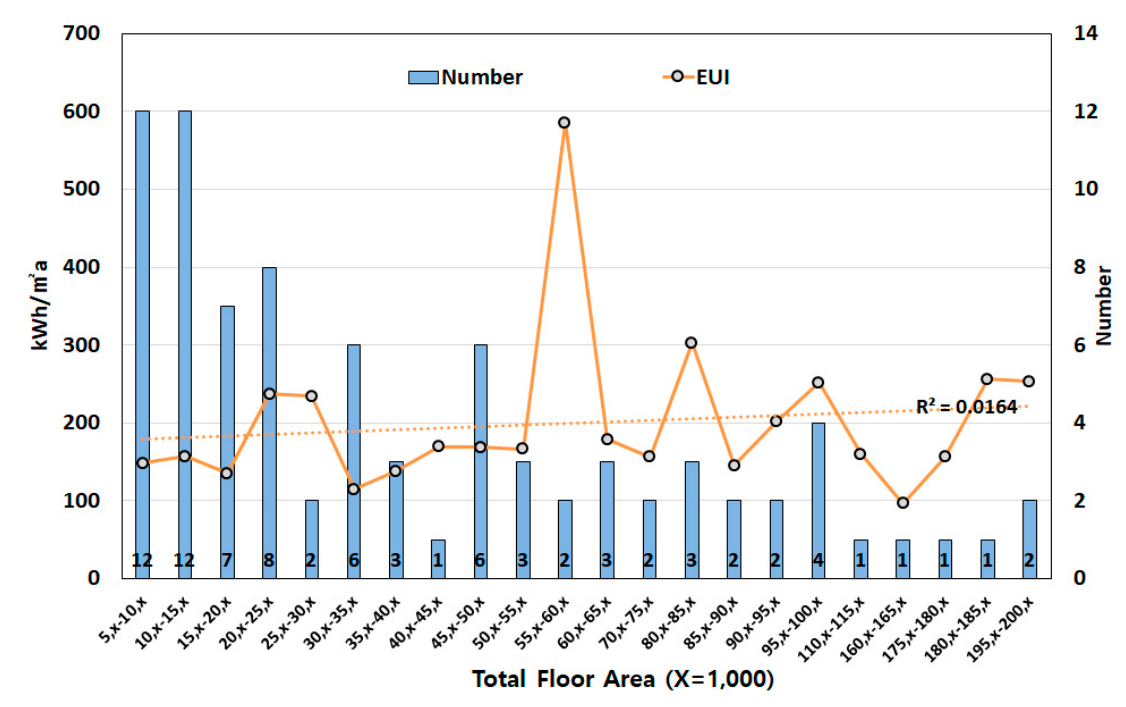
Figure 6. EUI average and number of samples by total floor area.